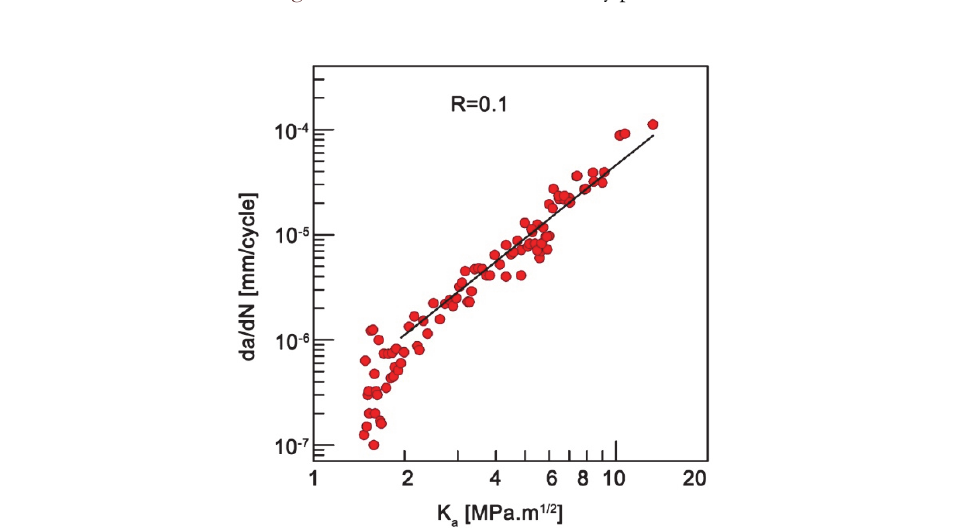
Figure 7: Structural details in the x-y plane